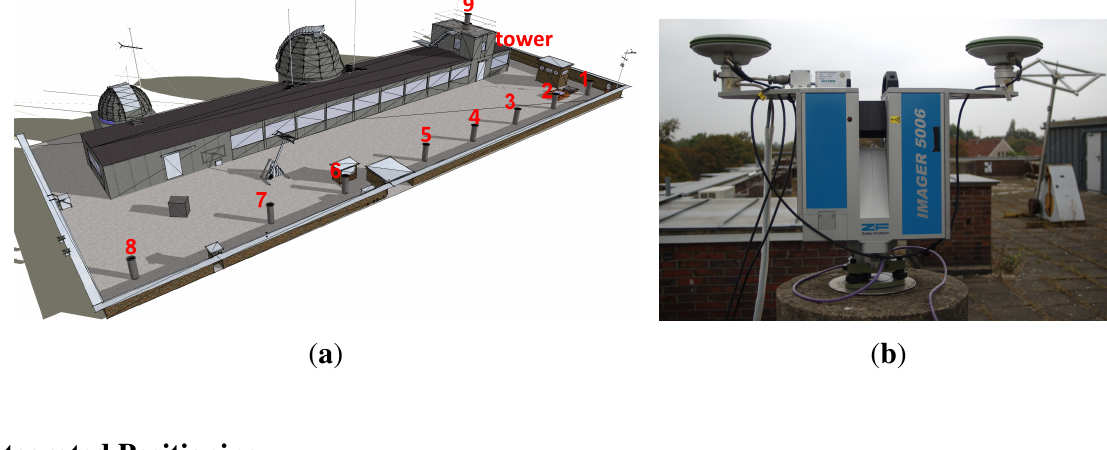
Figure 2. Multi-sensor experiment set-up on the roof of the building of the Geodetic Institute (Messdach), Leibniz Universit ¨ at Hannover, Germany. The MSS is mounted on Pillar 5, while the reference station is located on Pillar 8. ( a ) Location; and ( b ) the MSS used in the